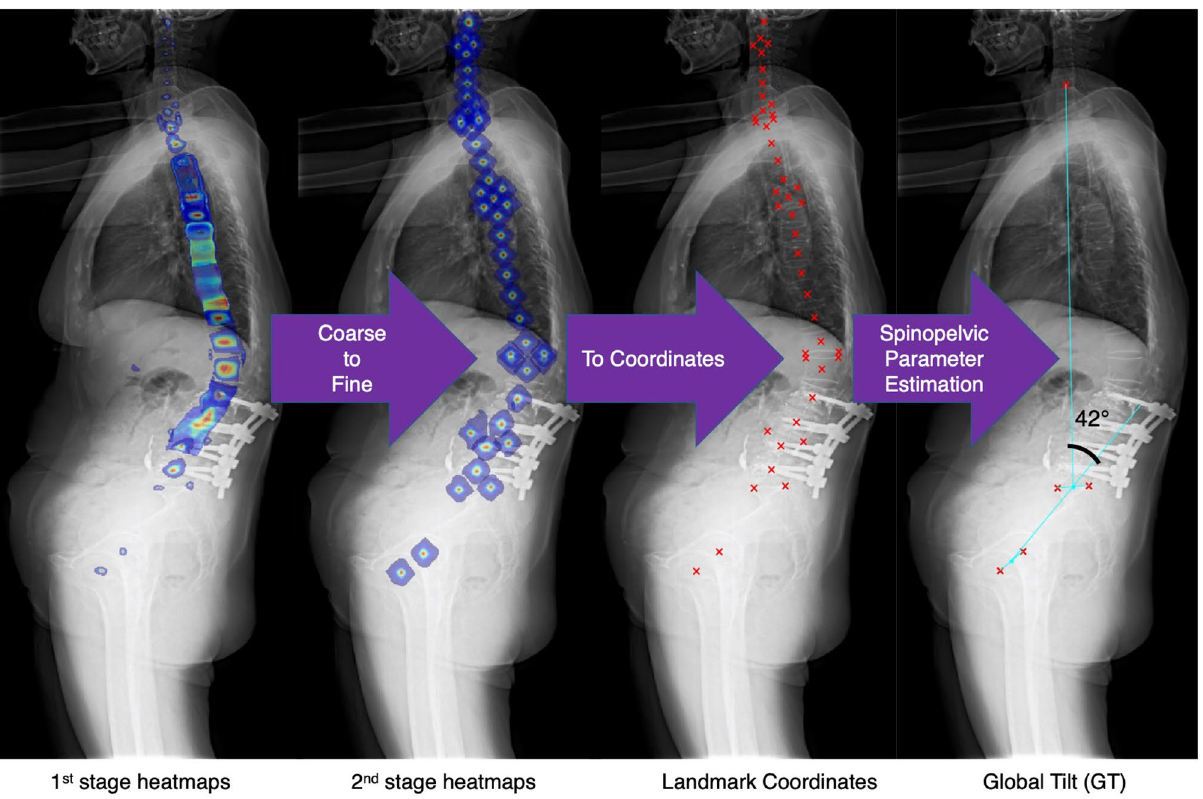
Figure 3. Automatic spine parameter estimation process. From the first to the second stage of the network, heatmaps of 45 landmarks were predicted from coarse to fine. Finally, the predictions of landmark coordinates were extracted from the fine (i.e. second stage) heatmaps. The predicted locations were then postprocessed to obtain 18 spine parameters (here, we plot ‘Global Tilt’ as an